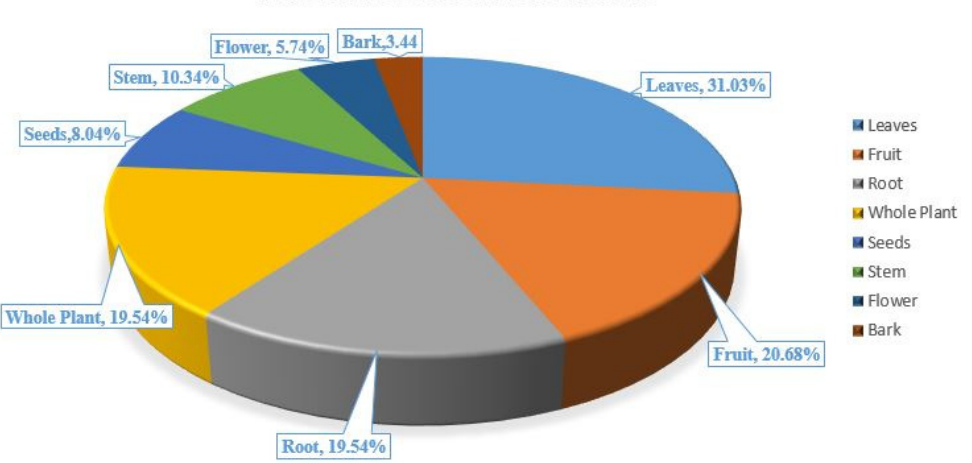
Figure 4. Analysis of the data showing a total estimation of plant parts used for the treatment of jaundice 1